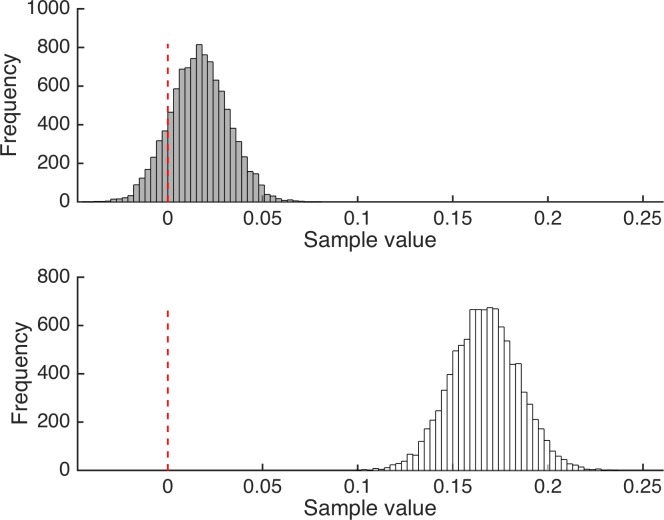
Bayesian analyses of the HV-D Effect on relative and absolute choice accuracy.(A) Histogram of posterior samples from a Bayesian t-test for the HV-D regression coefficients on relative choice accuracy. The analysis includes the coefficients from all 123 participants that conducted the task with short deliberation time (as in Chau2014). As can be seen, the posterior distribution largely overlaps with 0 (highlighted by the red dashed line). (B) The same analysis for absolute choice accuracy. Here, there is almost no overlap with 0.